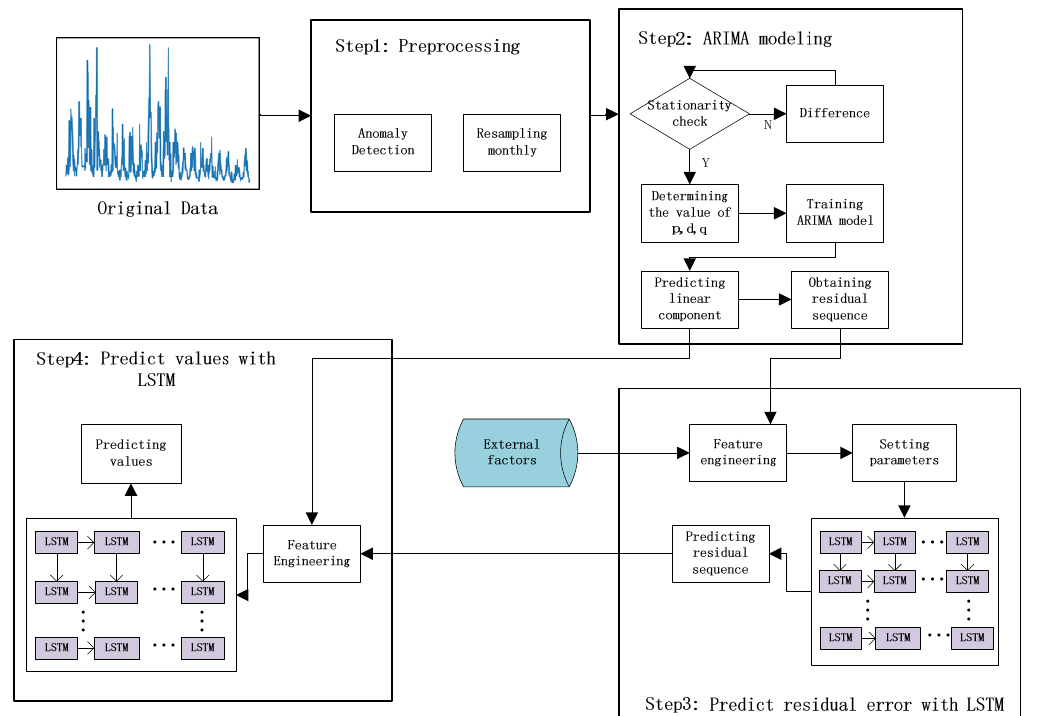
Figure 3. The architecture of our intelligent data analysis system combining ARIMA and LSTM.